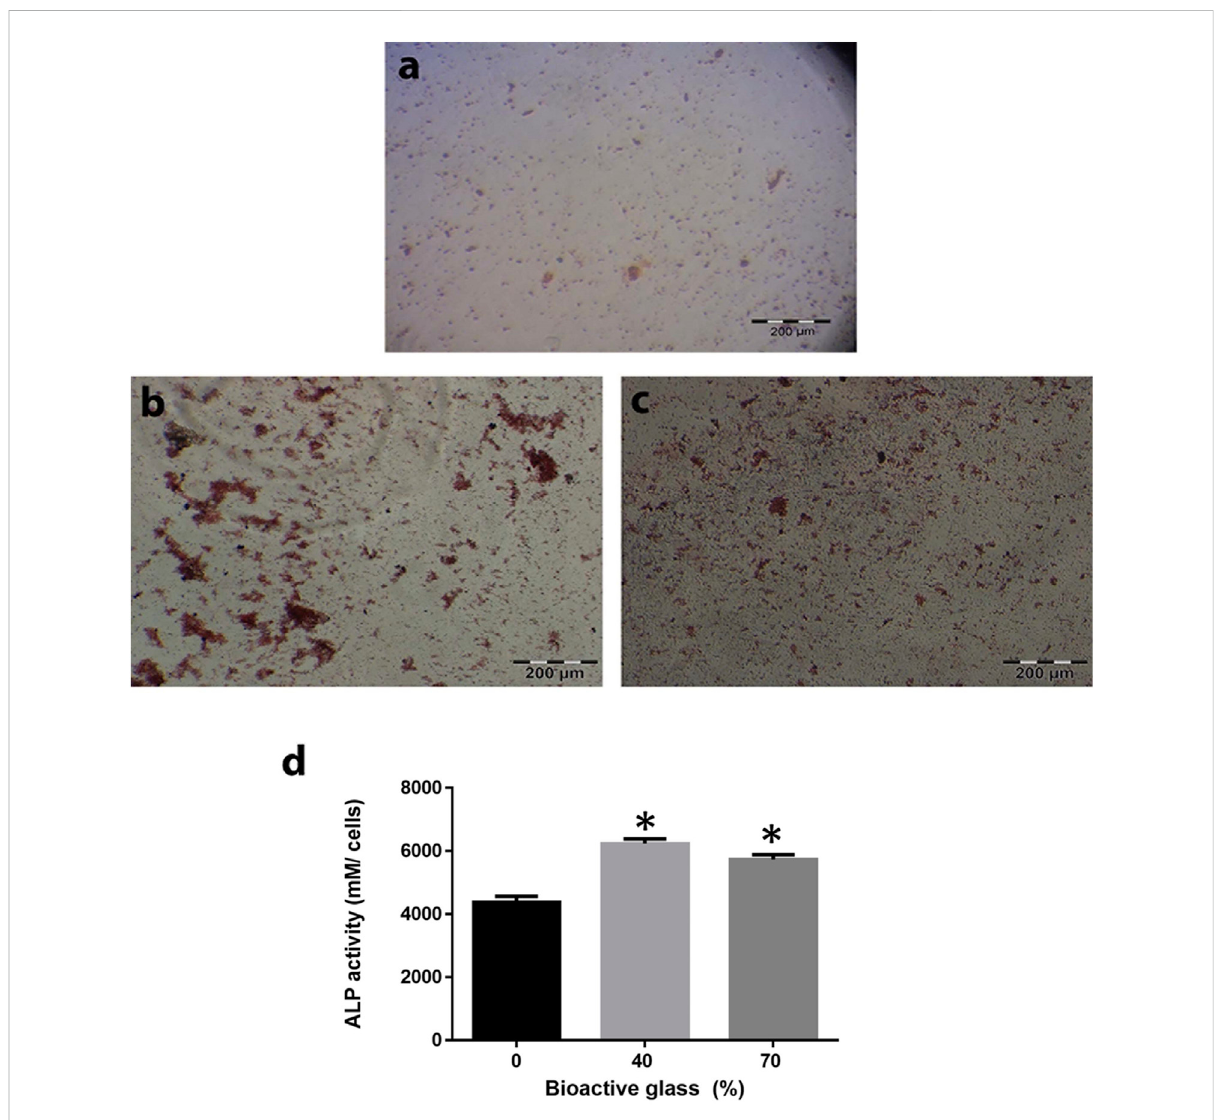
FIGURE 6 Effect of the different scaffold compositions in induction of differentiation of bone marrow mesenchymal stem cells (BM-MSCs) toward osteoblast lineage. Calcium depositions that produced by BM-MSCs have been shown by alizarin red staining for BG/collagen-PGA: (A) 0/100; (B) 40/60; (C) 70/30w/wculturedinbonedifferentiationmediaafter21 daysat37 ° Cina5%CO 2 .RednodulesareshowntheECMdepositionasaresult of osteogenesis. (D) Alkaline phosphatase activity as an index of osteogenesis was also calculated for BM-MSCs culture within all three types of thescaffold.Eachexperimentalprocedurewasrepeated threetimes.Thedataareshown asmean±SD.* p ≤ 0.05wasconsideredassigni fi cant.ALP activity was signi fi cantly higher in BG/collagen-PGA: 40/60 and BG/collagen-PGA: 70/30 rather than control BG/collagen-PGA: